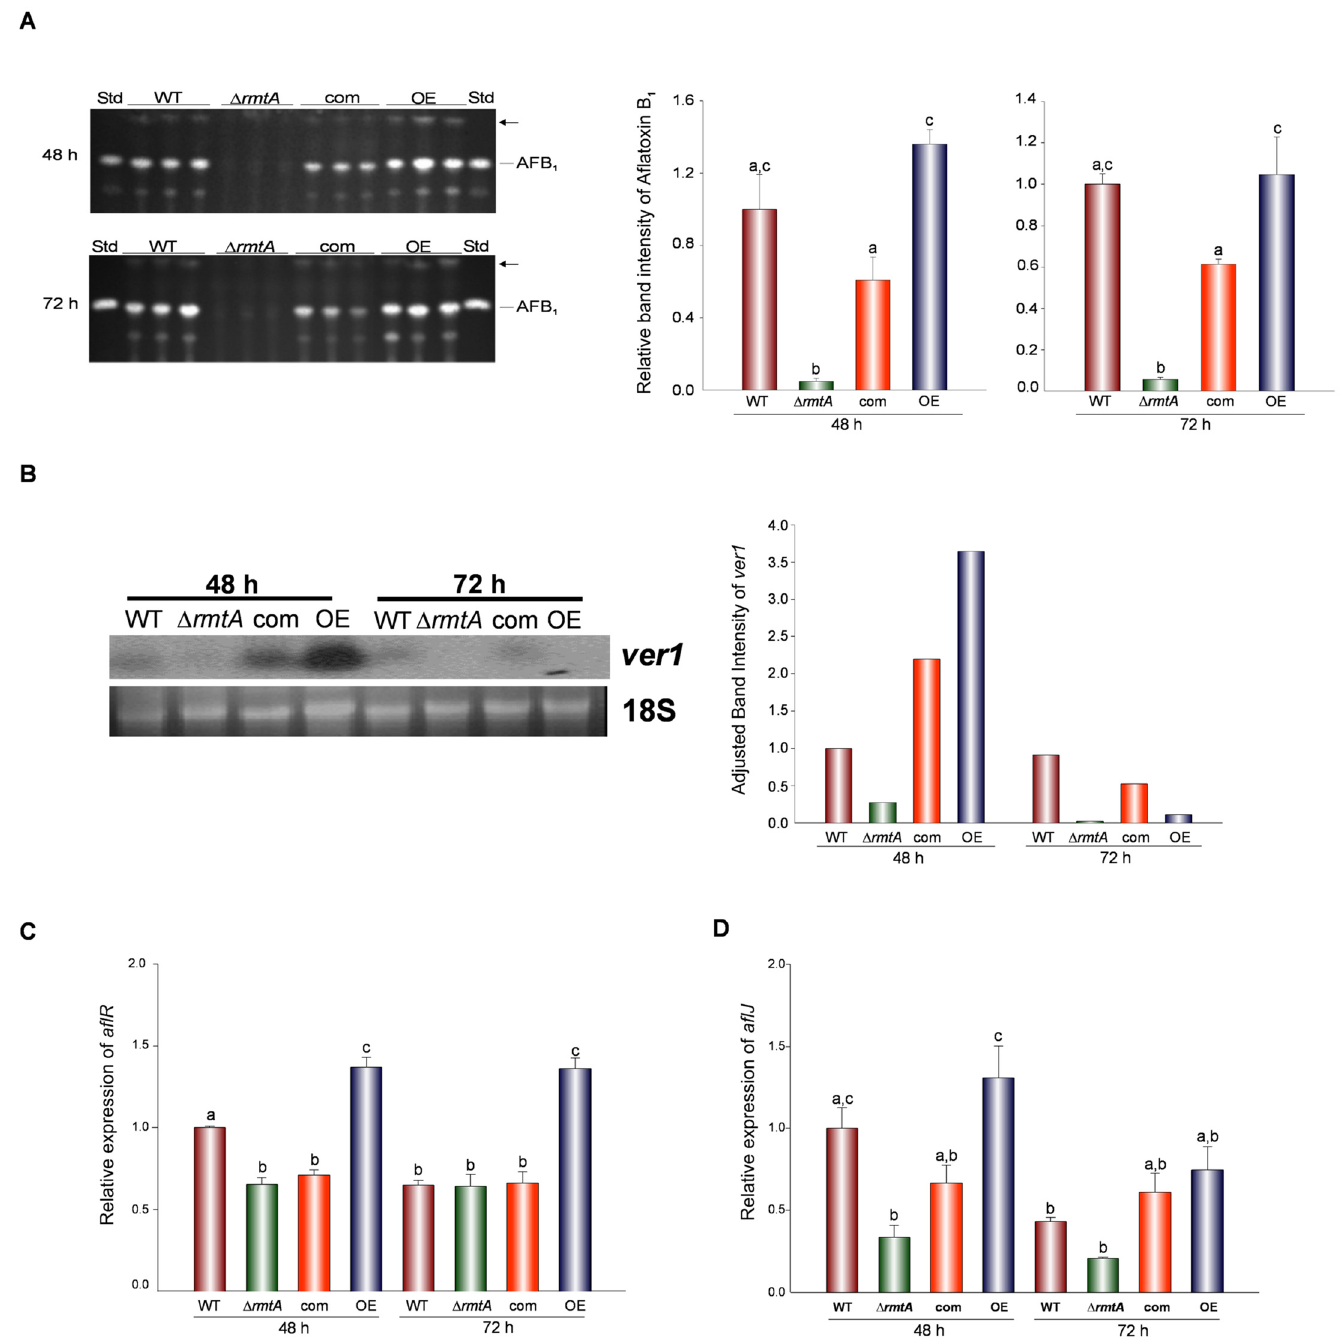
Fig 6. rmtA positively regulates Aflatoxin B 1 production. (A) TLC analysis of aflatoxin B1 produced by A . flavus wild type (WT), Δ rmtA , complementation (com) and OE rmtA (OE) strains growing at 30°C on PDA top-agar inoculated cultures for 48 h and 72 h. Aflatoxin standard (AFB 1 ) was also included on either side of the plate. Arrow indicates an unknown metabolite whose synthesis is also affected by rmtA . Densitometry of aflatoxin performed using GelQuantNET software is shown. (B) Northern Blot analysis of ver1 . All strains were grown in PDB stationary cultures (10 6 spores/ml) for 72 h at 30°C. 18S rRNA was used as loading control. Densitometry of Northern blot results is shown. (C & D) Expression analysis of aflR and aflJ by qRT-PCR respectively. The error bars represent standard errors. Different letters on the columns indicate values that are statistically different (p <